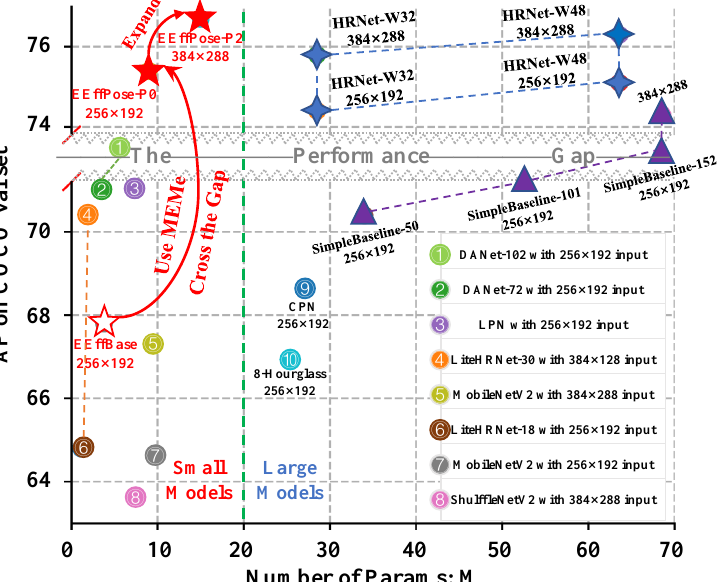
Figure 1. Demonstration of the performance gap (in gray) and comparison of our models (in red) with others. In the figure, the model with less parameters numbers and higher AP is more efficient and effective, respectively. Efficient baseline (EffBase) means our baseline model transformed from EfficientDet. While efficient and effective pose (EEffPose) is reconstructed from EffBase by using our mutually enhanced modeling method (MEMe). It is noteworthy that our MEMe-based models (EEffPose-P0 and its expanded version EEffPose-P2), cross the performance gap, archive the state-of- art among small models, and even surpass HRNet—the typical representative of large